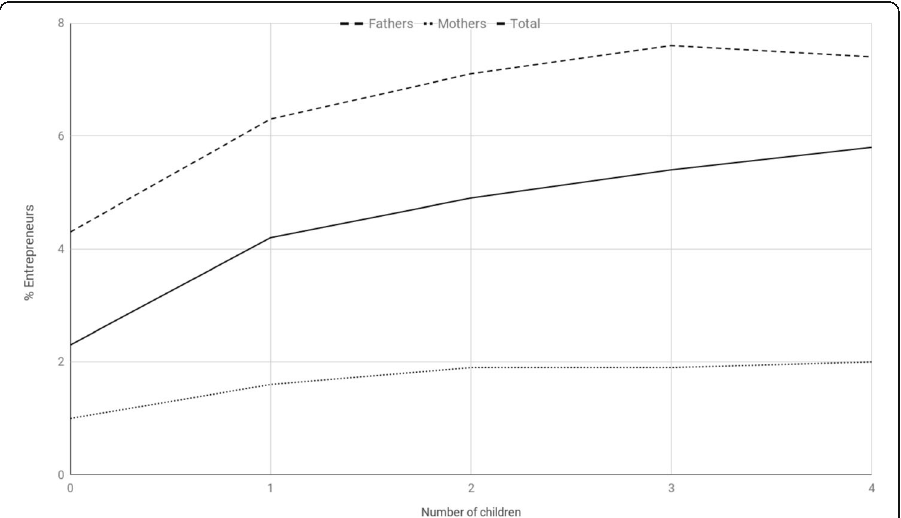
Fig. 1 Number of children and entry into business